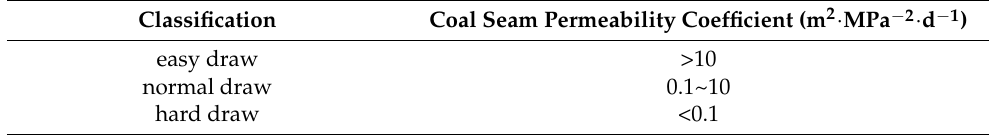
Table 1. Coal seam permeability coefficient classification.